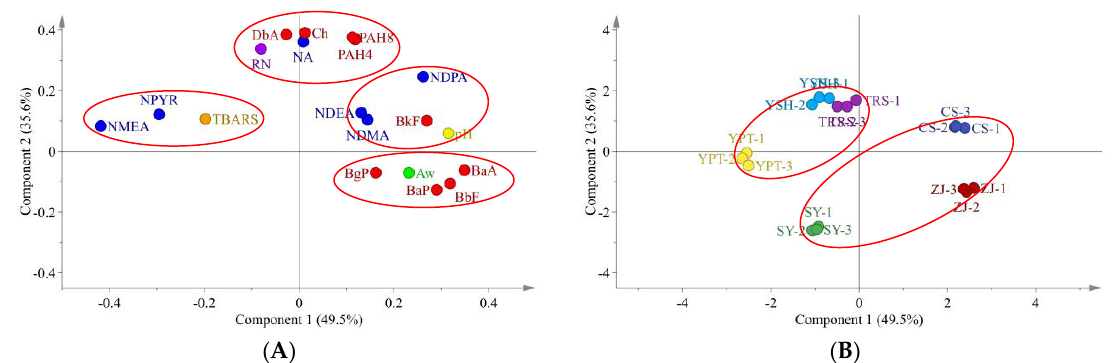
Figure 1. PCA loading plot in the plane of principal component 1 vs. principal component 2 ( A ), and PCA score plot of Larou products from artisanal and industrial origin ( B ) ( n = 3/group). Abbreviations: Aw, water activity, PAH, polycyclic aromatic hydrocarbon, NA, nitrosamine, RN, residual nitrite, TBARS, thiobarbituric acid reactive substances, NDMA,